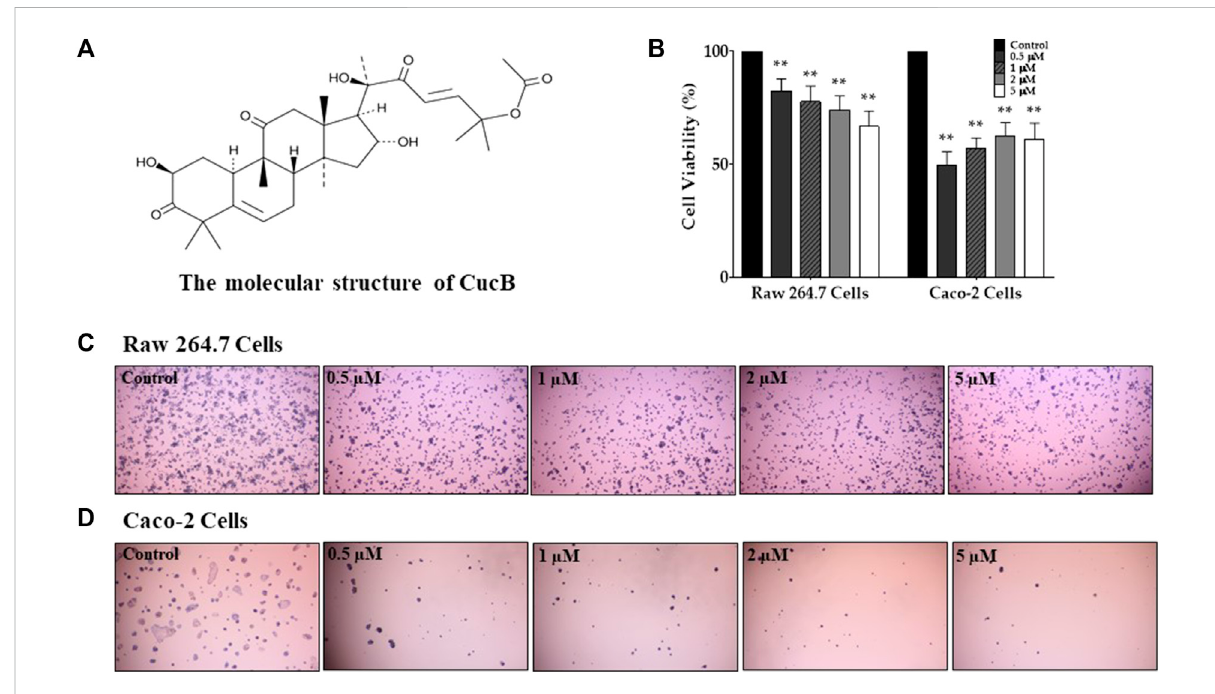
FIGURE 4 Assessment of the cytotoxic effect of cucurbitacin B (CucB). The chemical structure of CucB (A) . The effect of four different doses of CucB on theviabilityofRAW264.7andCaco-2cells (B) andtheirmorphologies (CandD) .Datawereexperimentsandwereexpressedasthemeanvalue±SD of three independent experiments. ** p < .01 vs. control with one-way